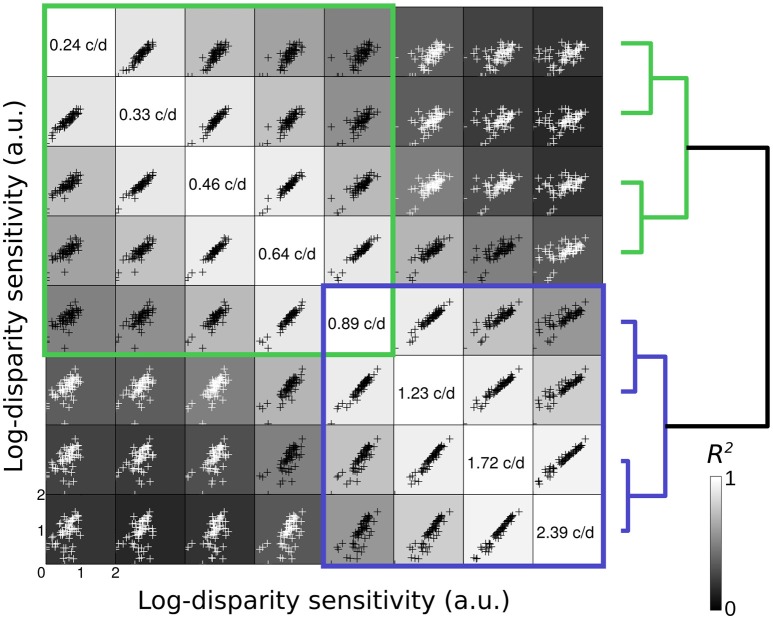
Scatterplot matrix of inter-correlations. In each cell, the scatterplot represent the inter-correlation of the log-disparity sensitivity (arbitrary units) of all 61 observer at one frequency (frequency indicated on the diagonal in the same row) as a function of their sensitivity at another frequency (frequency indicated on the diagonal in the same column). The shade of the background in each cell indicates the value of the coefficient of determination R2 between the two frequencies (from black = 0 to white = 1). Black datapoints indicate R2 > 0.5 and white datapoints R2 < 0.5. Blue and green squares highlight regions of high inter-correlations. On the right is represented the classification dendrogram of the spatial frequencies. The pairwise distance was calculated as one minus the sample linear correlation between observations and the hierarchical cluster tree was computed with the average distance.